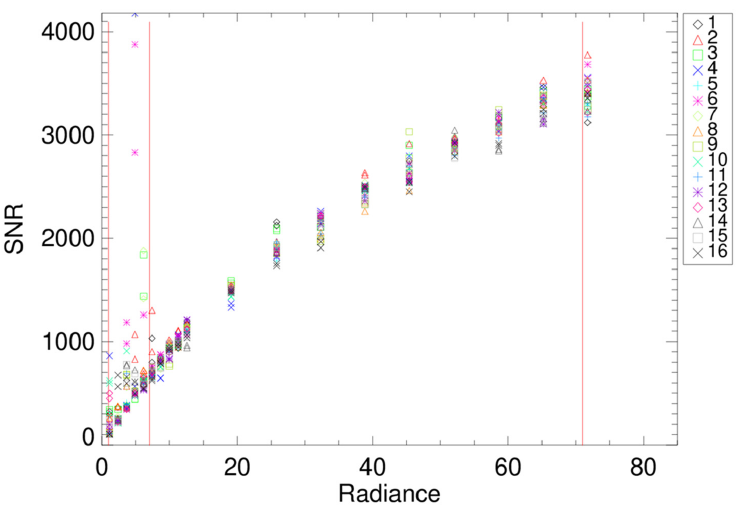
Figure 12. The signal-to-noise ratio (SNR) of band M10 for all detectors (colored symbols) as a function of SIS100 radiance (W/m 2 /µm/sr). The three vertical red lines are for Lmin (left), Ltyp (middle), and Lmax (right).